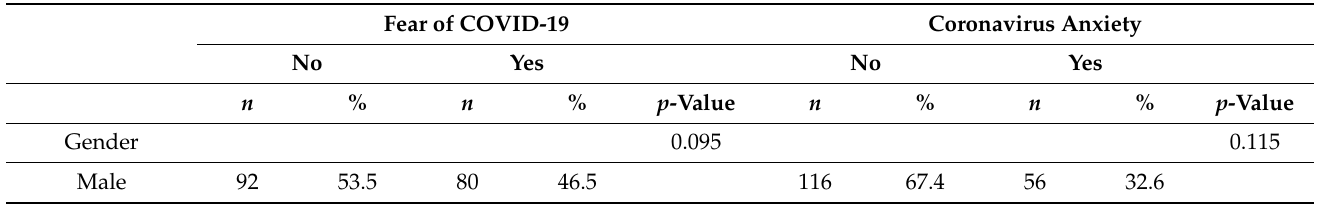
Table 2. Fear of COVID-19 and coronavirus anxiety according to the socio-demographic and clinical